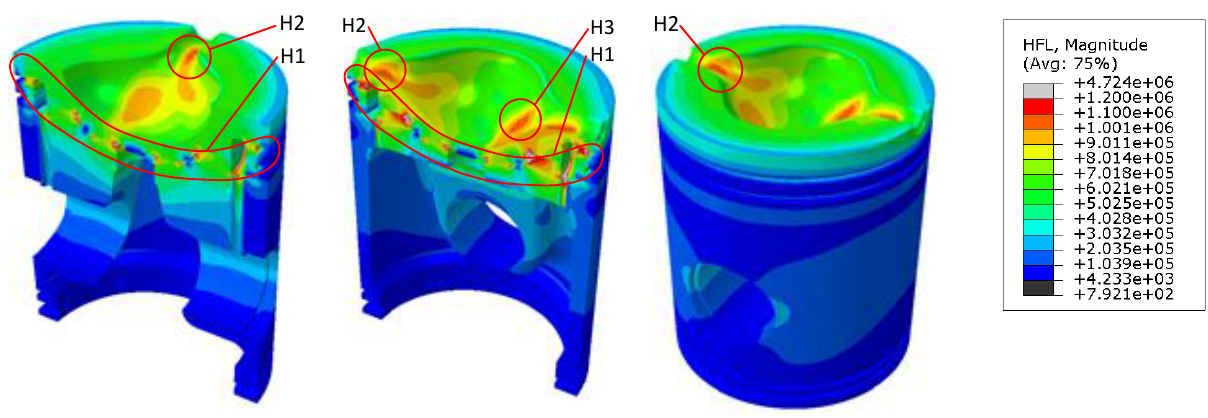
Fig. 12. Distribution of heat flow density on the surfaces of the